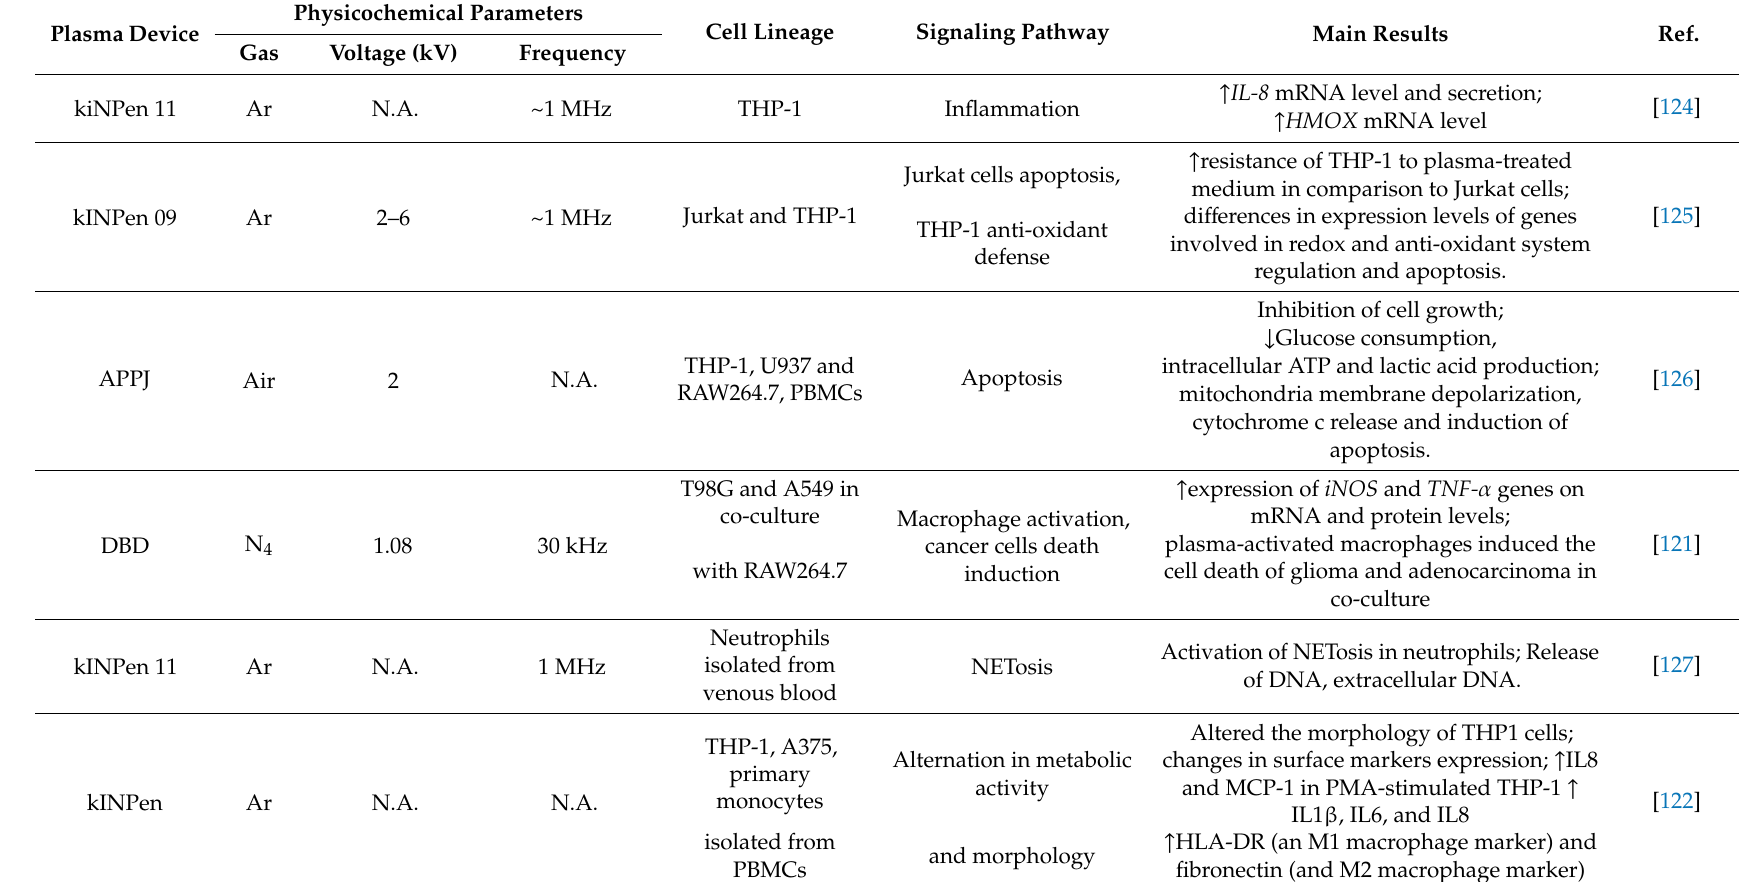
Table 3. Generalized summary of NTP modulation of immune cell activity in